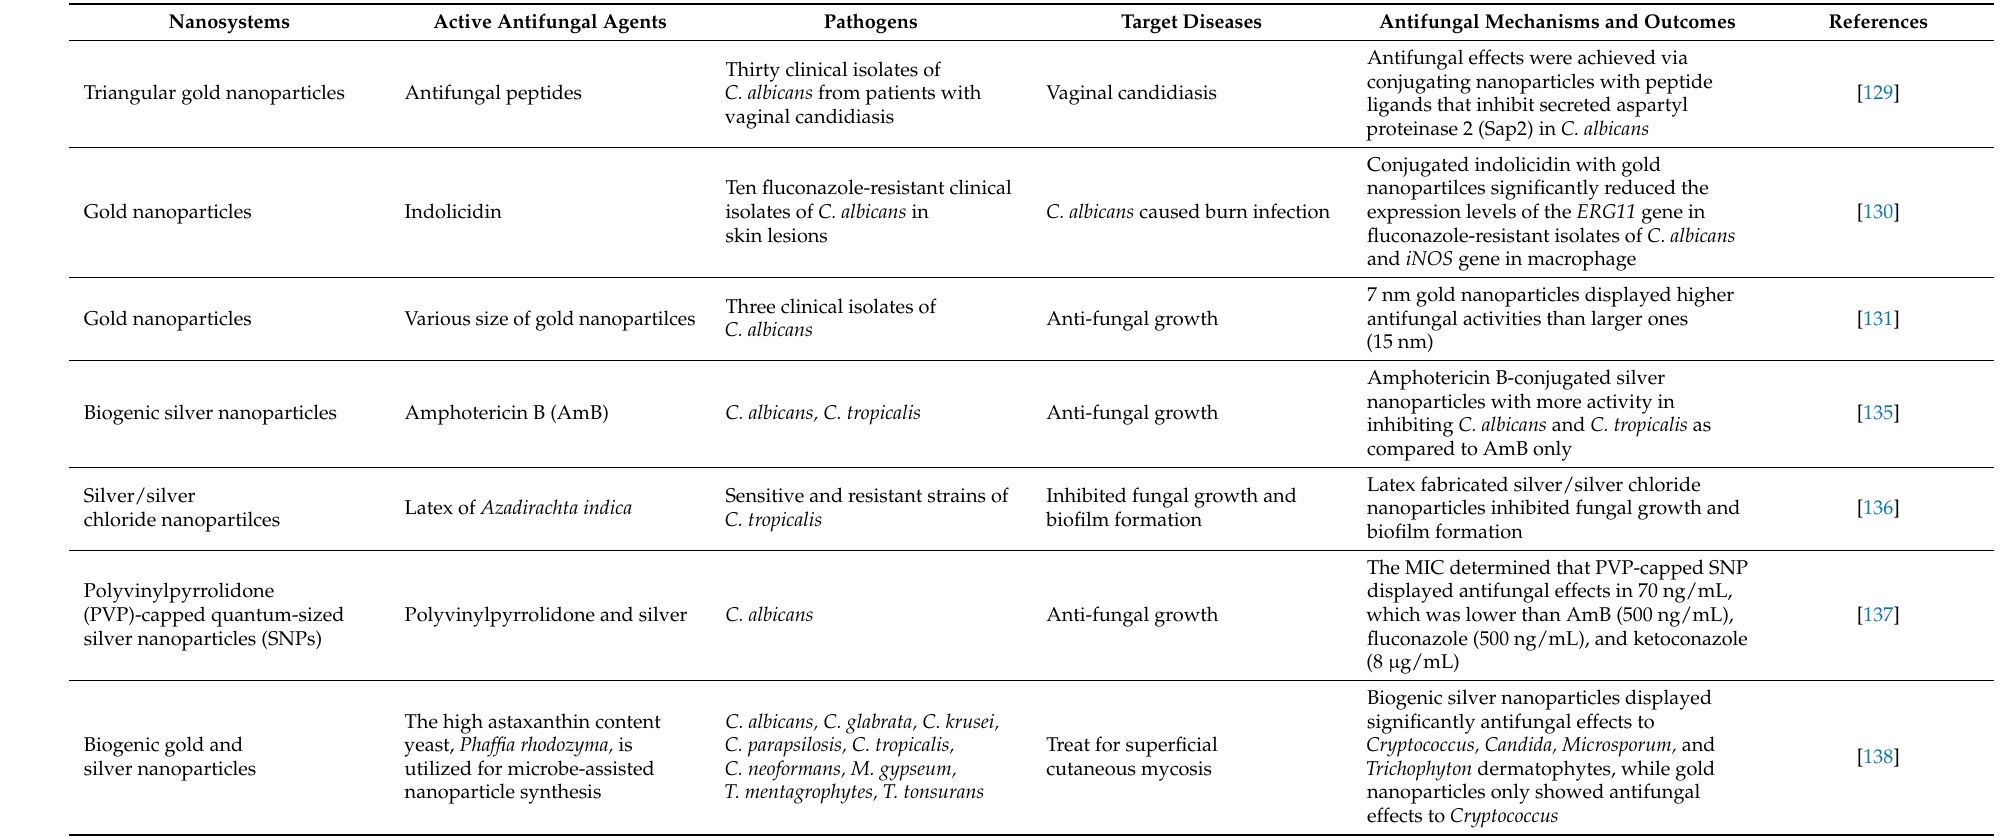
Table 3. Metallic Nanoparticle based antifungal therapeutic